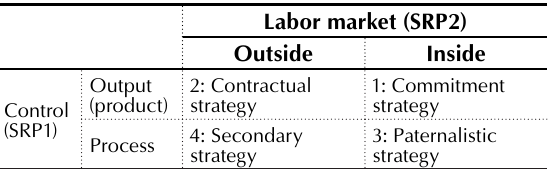
Table 1. The integrated model of formulating human resource strategy (Bamberger and Meshoulam)